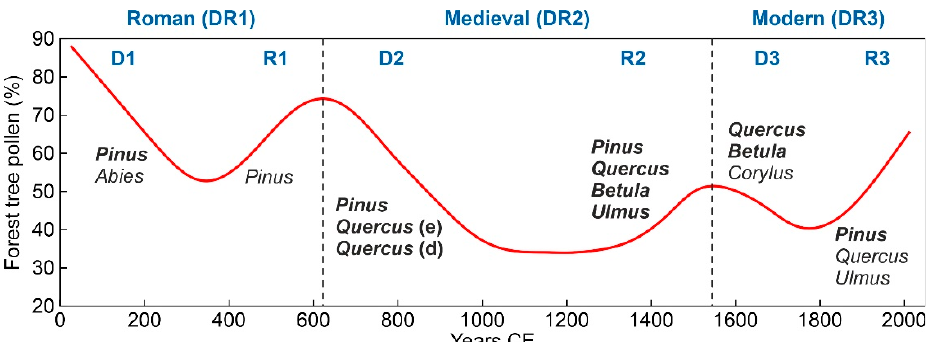
Figure 11. Characterization of the different deforestation (D) and forest regeneration (R) phases in terms of the individual forest types that significantly decreased or increased, according to the results of correlation analysis. Correlations significant at p < 0.01 are in bold, and those significant at p < 0.05 are in normal font (Table 3). The general forest trends are represented with a red line (Figure 4).